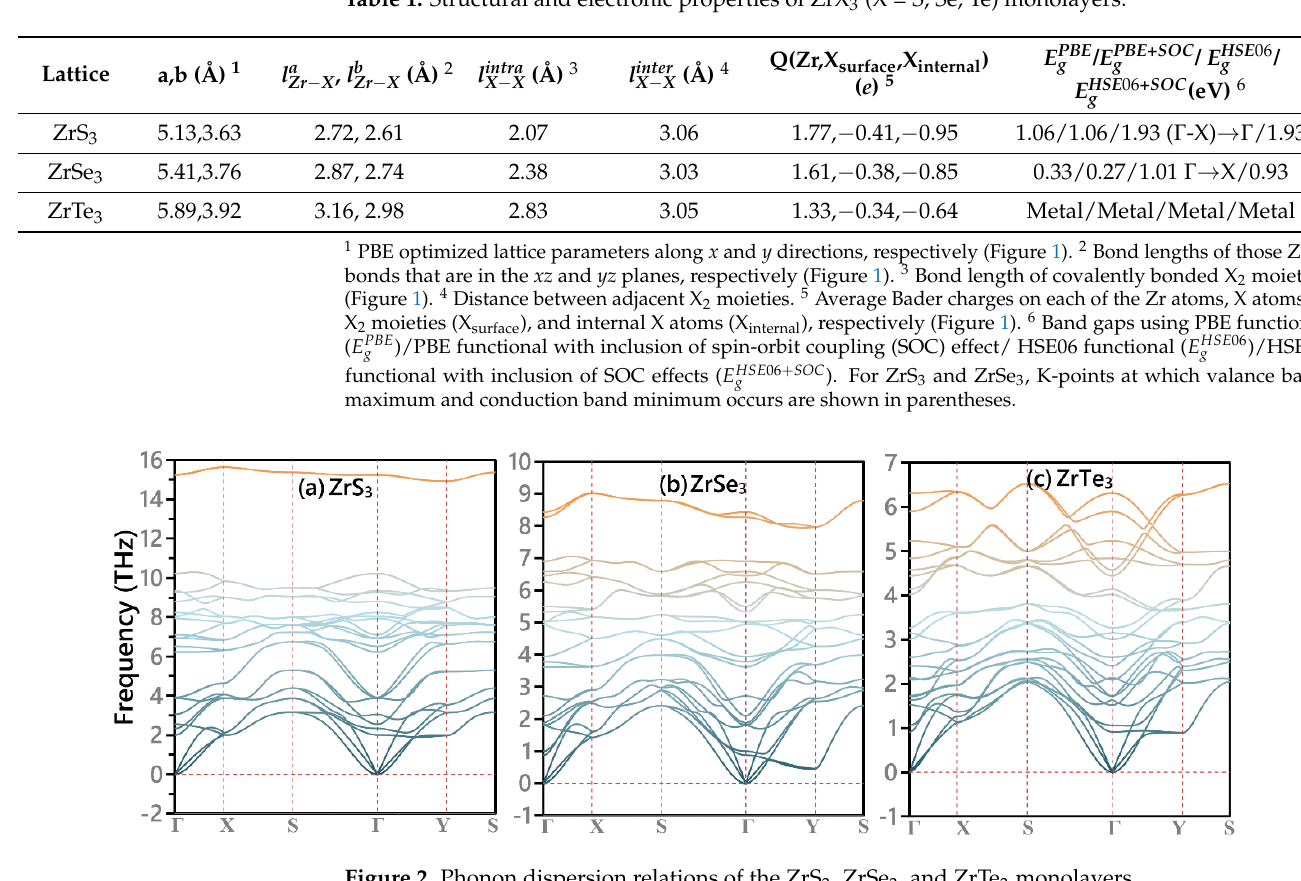
Table 1. Structural and electronic properties of ZrX 3 (X = S, Se, Te) monolayers.